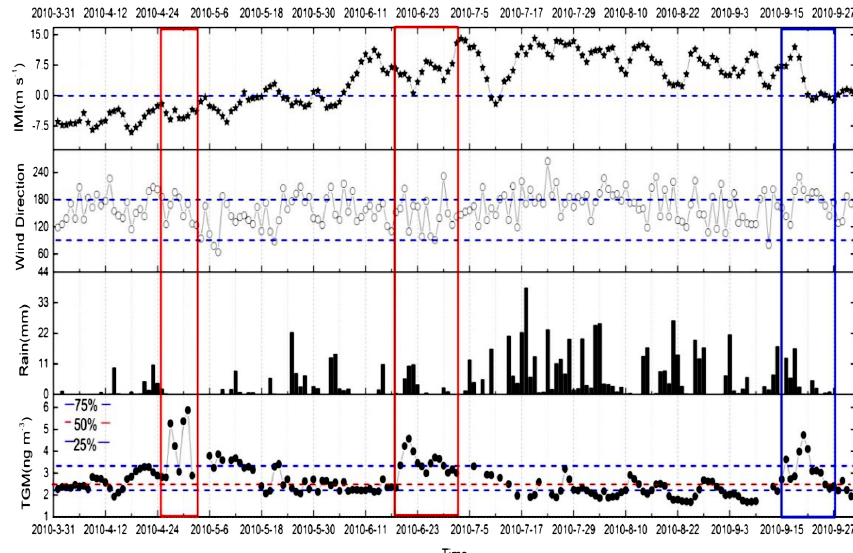
Figure 7. Time series of WD, RF and TGM and the calculated Indian monsoon index (IMI) from April to September 2010. An IMI value >0 indicates air movement from south toward north, which is also associated with greater precipitation. WD measured at SAWRS was mostly from the southeast. Zero IMI indicates weak air movement. Negative IMI indicates northerly wind that pushes the air back to the Indian Ocean. Areas highlighted in red show times when the causes of these events are impacted not only by local airflow but also long-term transportation, while the blue area just represents the local airflow impact.